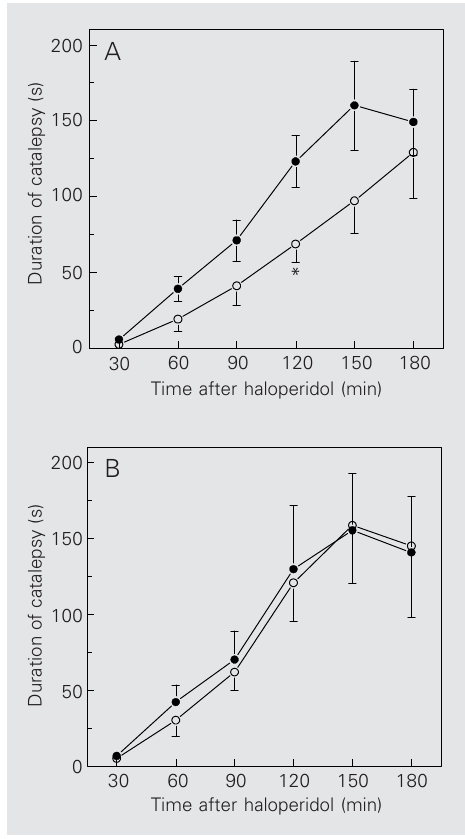
Figure 3. Effects of S-nitroso-N- penicillamine (SNAP) on neuro- leptic-induced catalepsy in male (A) and female (B) mice. SNAP, or vehicle as control, was in- jected ip 30 min before halo- peridol (1 mg/kg, ip ). Data are reported as means ± SEM, N = 10 mice per group. Filled circles, vehicle; open circles, 20 mg/kg SNAP. *P<0.05 compared to vehicle (Dunnett test).